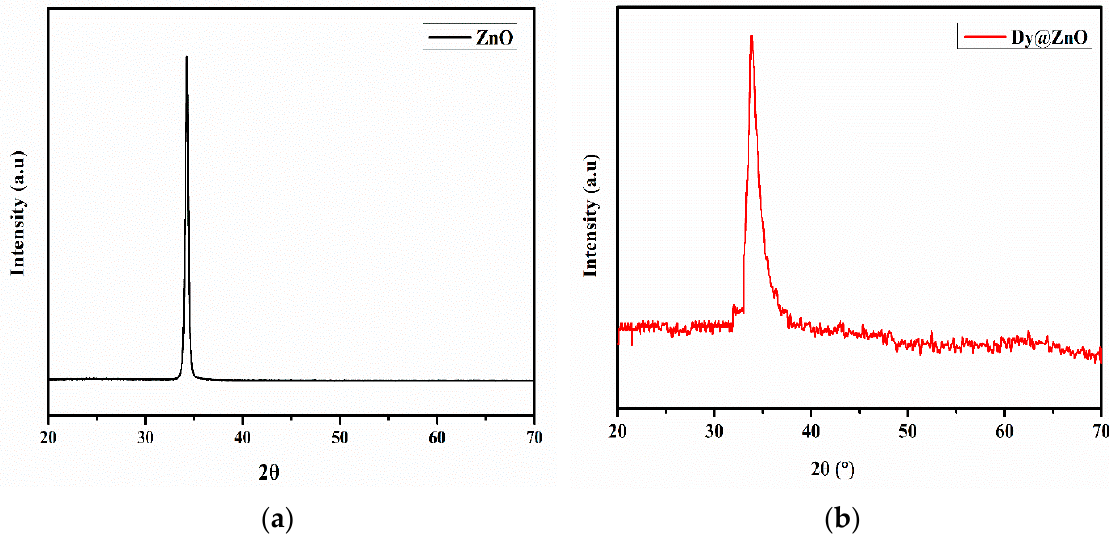
Figure 3. X-ray diffraction pattern of undoped ZnO thin film ( a ) and Dy-doped ZnO ( b ).